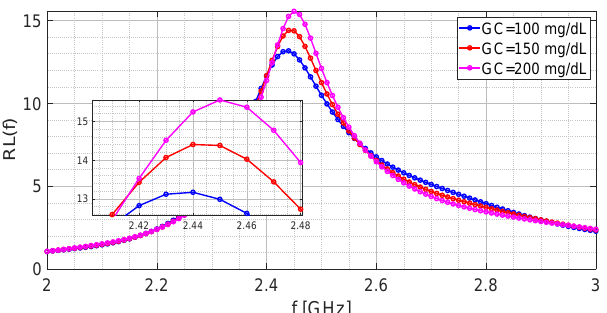
Figure 7. Return loss measured by the microwave-resonant sensor for different glucose concentra-